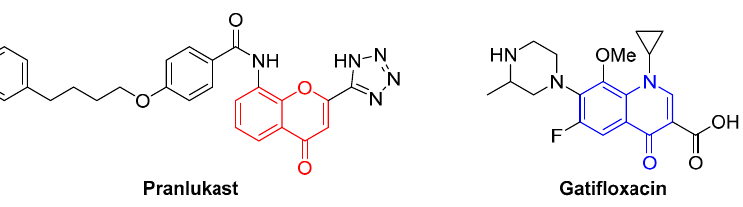
Figure 1. Examples of chromone- and quinolone-containing drugs.